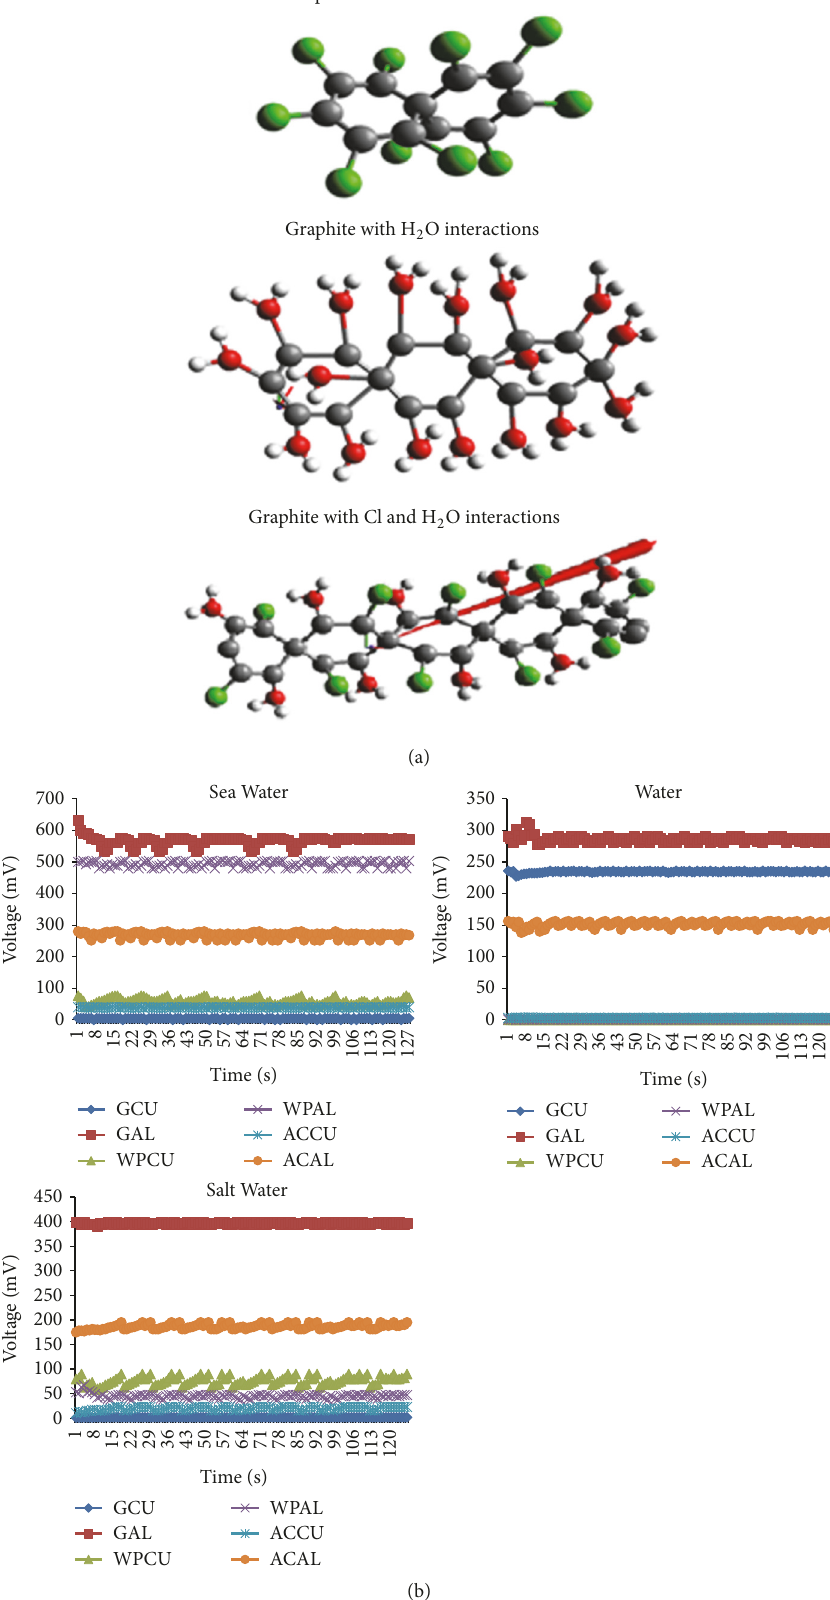
Figure 7: (a) Model of graphite interactions. (b) Response of electricity of sea water, water (H 2 O), and salt